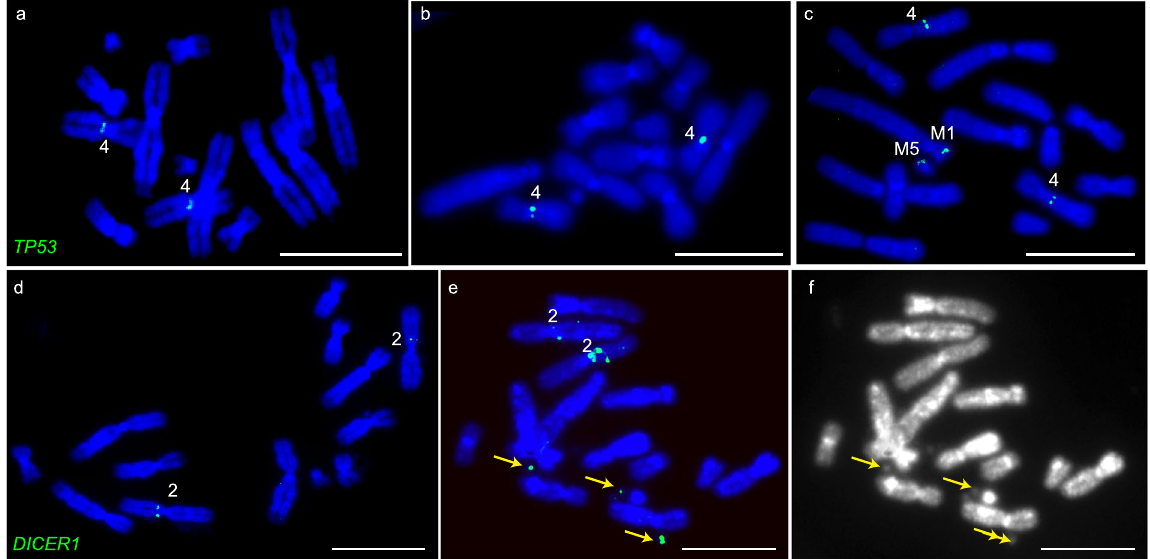
Figure 6. ( a ) TP53 is located on chromosome 4 on normal devil chromosomes and ( b ) in DFT1 sample 06.1926. ( c ) TP53 is located on two additional chromosomes (M1 and M5) in sample DFT1 06.2109. DICER1 localises to ( d ) chromosome 2 on normal devil chromosomes. ( e ) In DFT1 sample 11.3178, DICER1 is amplified on double minutes (indicated by arrows). ( f ) DAPI image to show that green fluorescent signals in ( e ) correspond to double minutes. Scale bars represent 10 μ m.